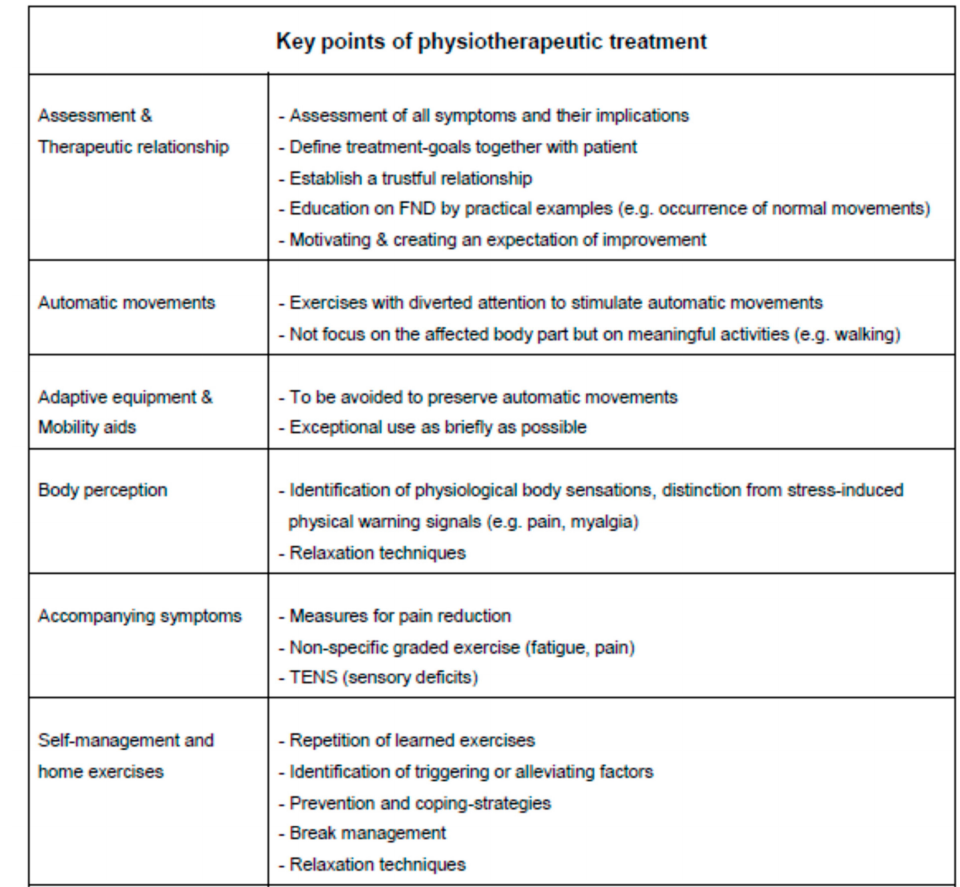
Figure 5. Key points of physiotherapeutic